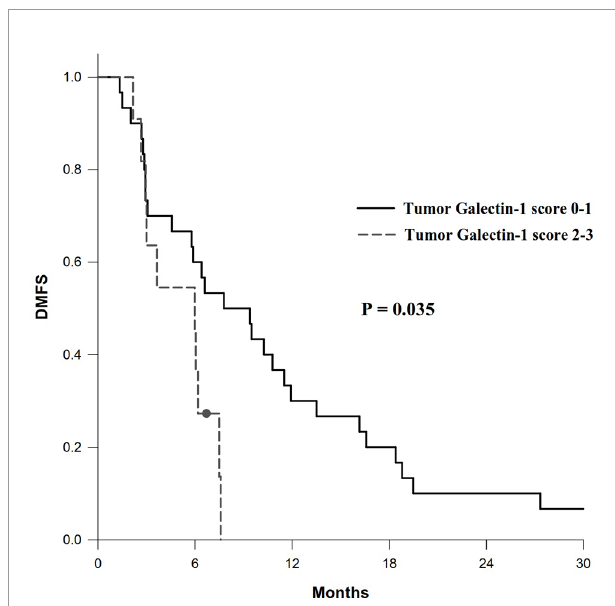
FIGURE 5 | Survival curve of distant metastasis-free survival (DMFS) according to overexpression (score 2 – 3) versus non-overexpression (score 0 – 1) of tumor galectin-1. The p -value was calculated using log-rank